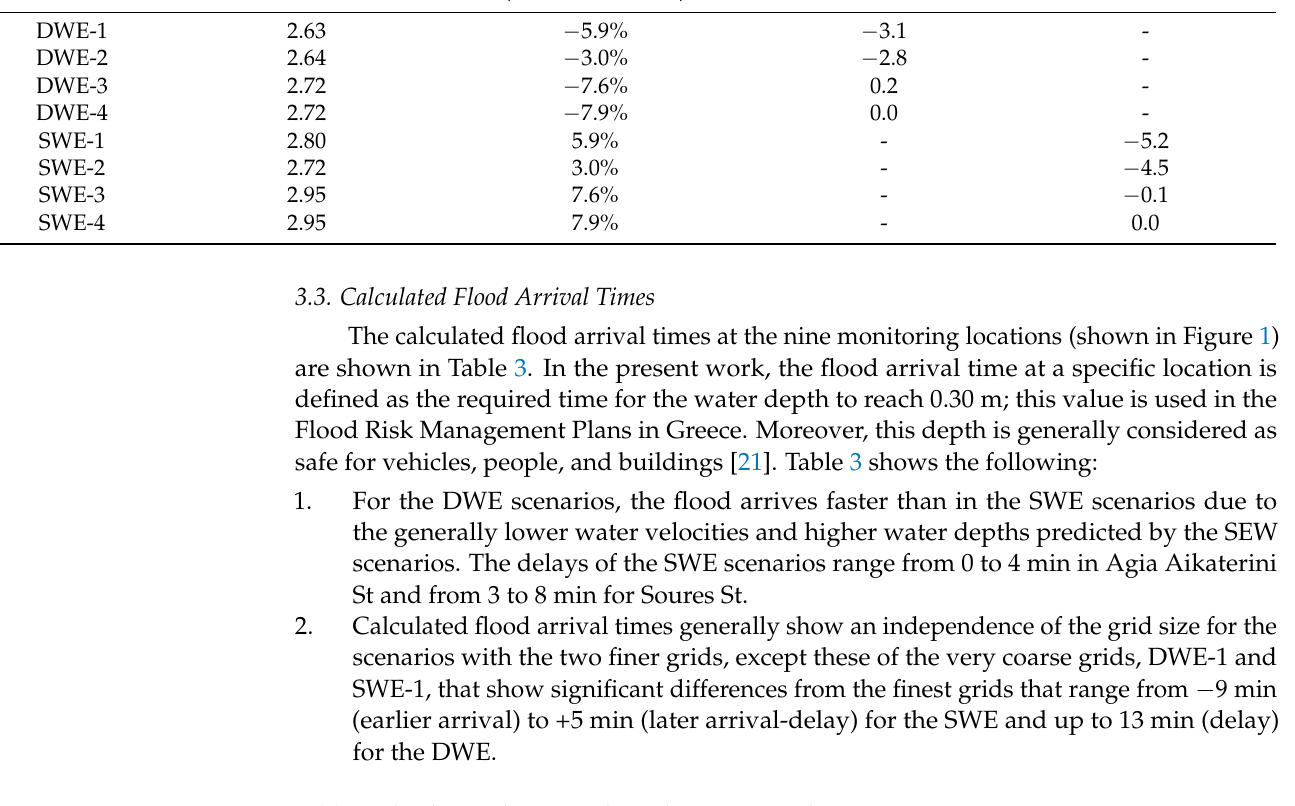
Table 3. Flood arrival times at the eight monitoring